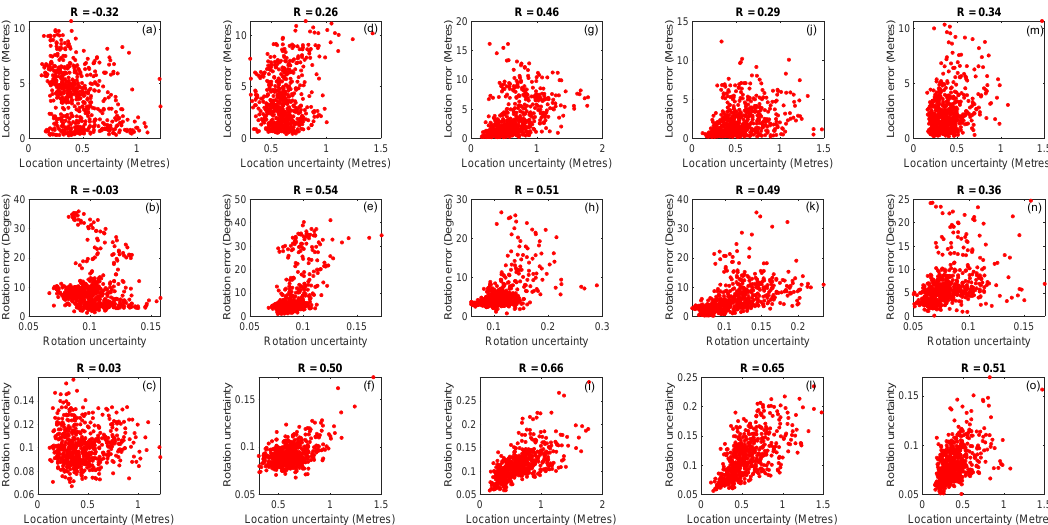
Figure 12. The uncertainty modelled by the network ( a – c ) fine-tuned using Syn-car and tested on real images, ( d – f ) fine-tuned using Syn-pho-real and tested on real images, ( g – i ) fine-tuned using Syn-pho-real-tex and tested on real images, ( j – l ) fine-tuned using Gradmag-Syn-car and tested on gradmag of real images, ( m – o ) fine-tuned using Syn-edge and tested on gradmag of real images. The first column shows the estimated location uncertainty vs. location error. The second column shows the estimated rotation uncertainty vs. rotation error, and the third column shows the estimated location uncertainty vs. estimated rotation uncertainty.